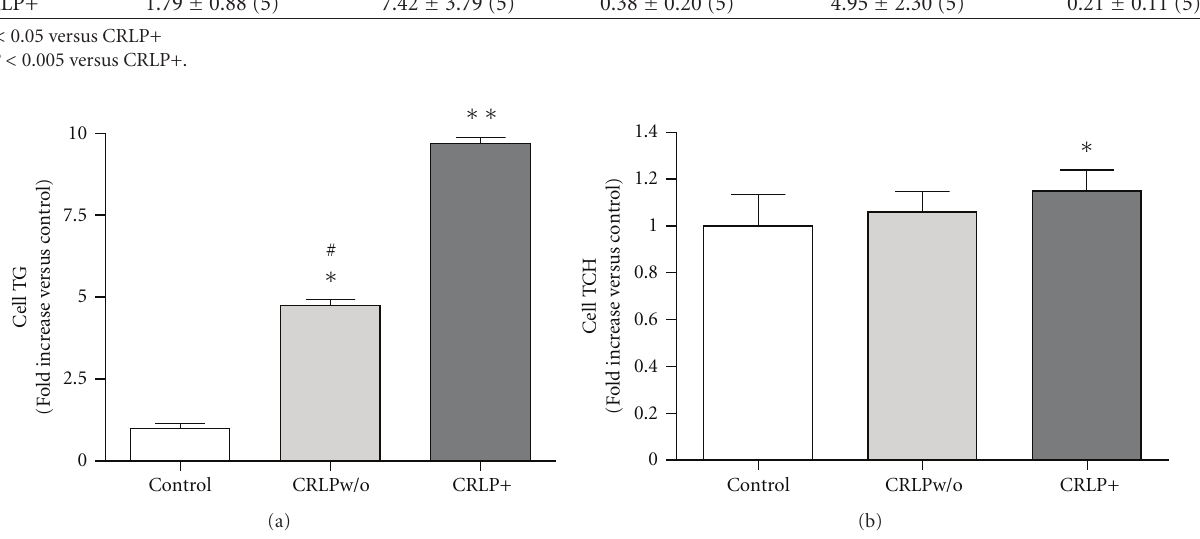
Figure 2: E ff ect of plasma treatment of CRLP on macrophage lipid accumulation induced by CRLP. HMDM were incubated for 24 h in serum-free medium without the addition of CRLP (control) or with 80 μ g cholesterol/mL of either CRLP+ (contains apoE) or CRLPw/o (lacks apoE). (a) Cellular TG; (b) total cholesterol (TCH) content was determined by fluorimetric assay (mean ± SD, n = 6). Results are expressed as increase of lipid content with respect to the control. ∗ P < 0.05, ∗∗ P < 0.001 versus control; # P < 0.05 versus